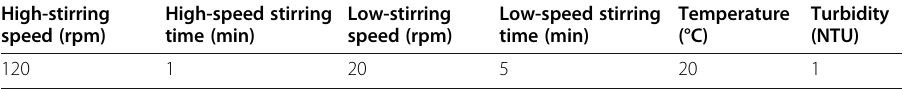
Table 4 Optimal hydraulic